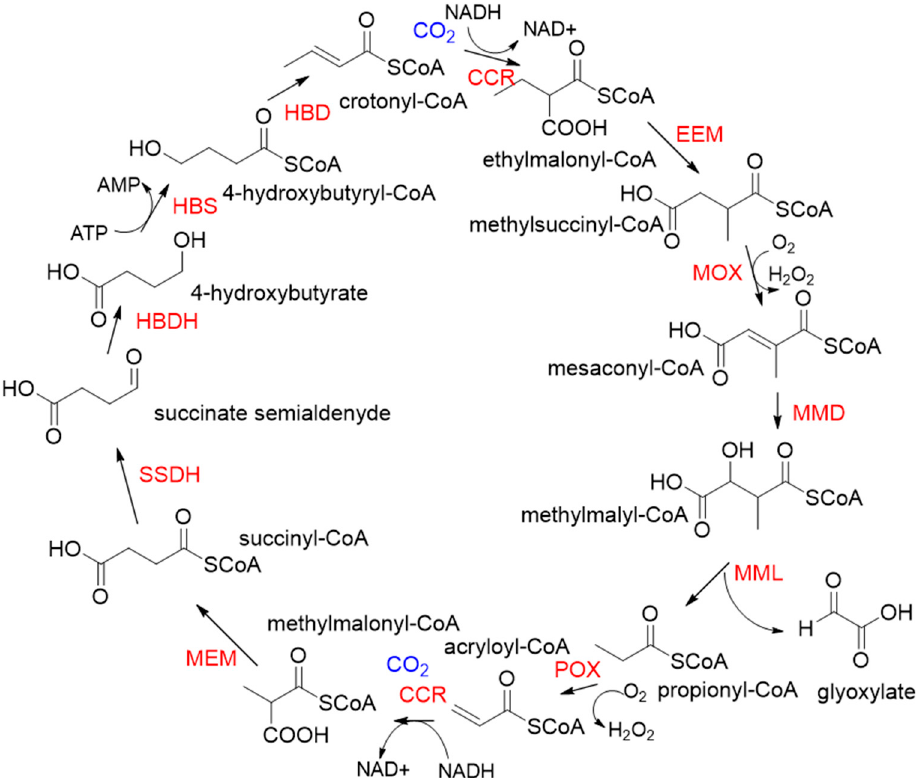
Figure 4. The crotonyl-CoA/ethylmalonyl-CoA/hydroxybutyryl-CoA cycle pathway (CETCH pathway) [21]. CCR, crotonyl-CoA carboxylase/reductase; EEM, ethylmalonyl-CoA epimerase, and mutase; MOX, methylsuccinyl-CoA oxidase; MMD, methylmalyl-CoA dehydratase; MML, methylmalyl-CoA lyase; POX, propionyl-CoA oxidase; MEM, methylmalonyl-CoA epimerase, and mutase; SSDH, succinate semialdehyde dehydrogenase; HBDH, 4-hydroxybutyrate dehydrogenase; HBS, 4-hydroxybutyryl-CoA synthetase; HBD, 4-hydroxybutyryl-CoA dehydratase.